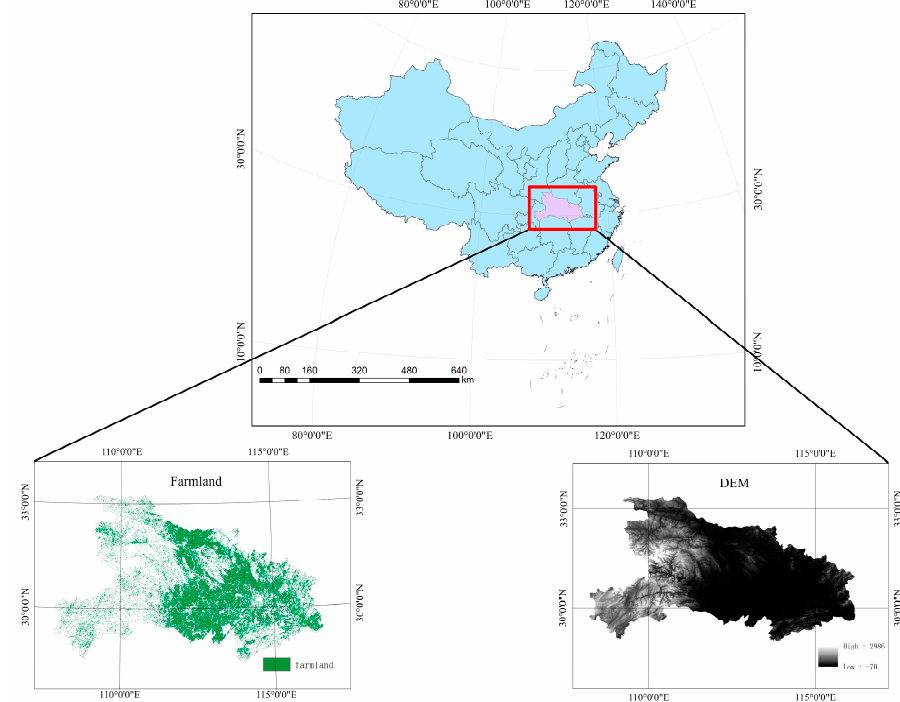
Figure 1. Location of Hubei Province in China.